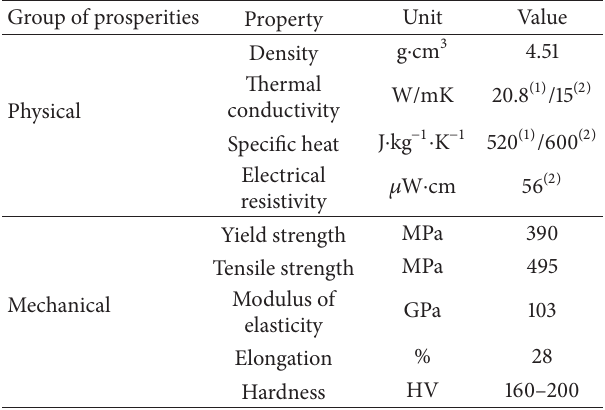
Table 4: Selected physical and mechanical properties of Titanium Grade (cid:3) 2